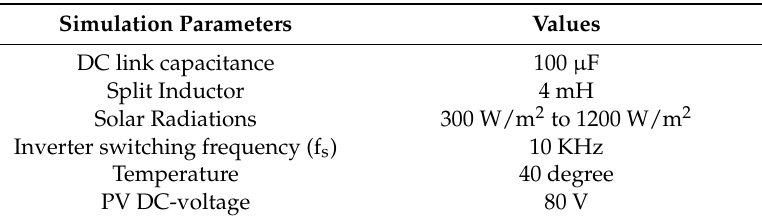
Table 1. Parameters used in simulation and